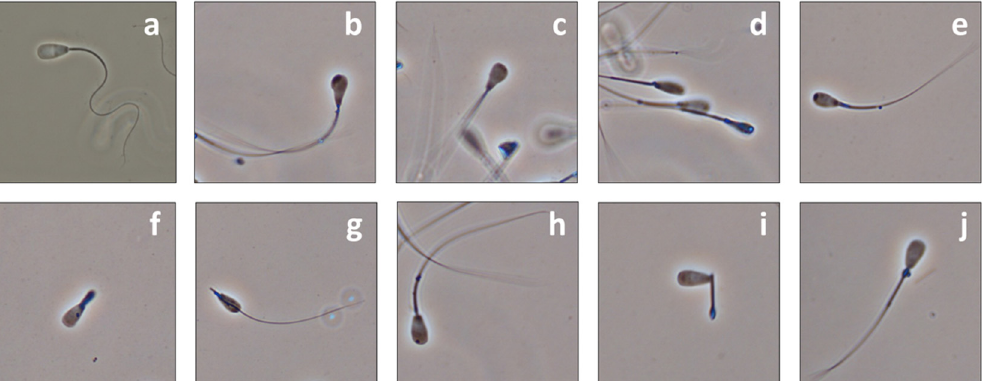
Figure 1. Morphology abnormalities of spermatozoa from homozygous carriers. In contrast to control individual ( a ) sperms of homozygous carriers showed head ( b – e ) and midpiece ( f – j ) anomalies. ( b ) Thickened apical region; ( c ) narrow postacrosomal region; ( d ) narrow sperm head size; ( e ) irregular heads with dense apical regions. ( f ) Swollen; ( g ) broken; ( h ) thickened midpiece; ( i ) cytoplasmic droplet (distal); ( j ) cytoplasmic droplet (proximal).